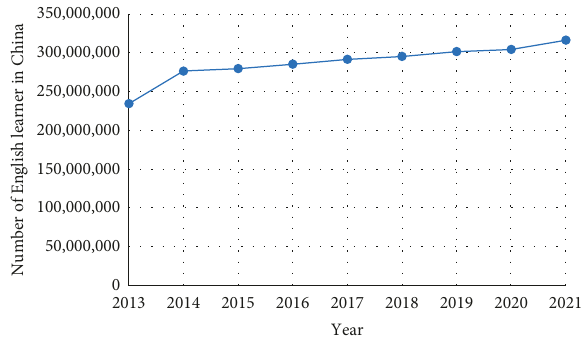
Figure 1: Number of English learner in China from 2013 to